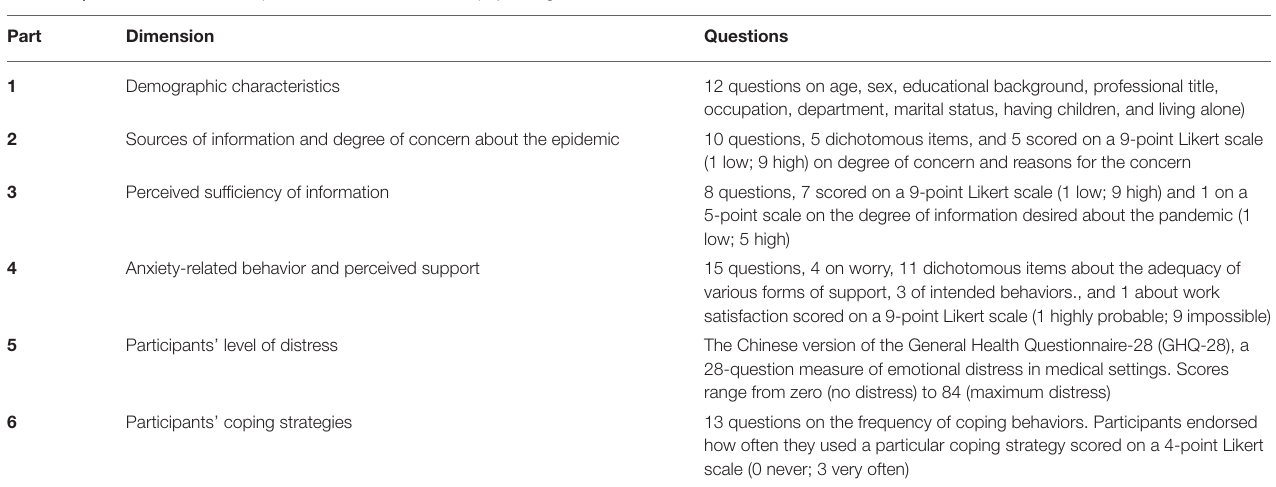
TABLE 1 | Characteristics of the questionnaire used to assess psychological